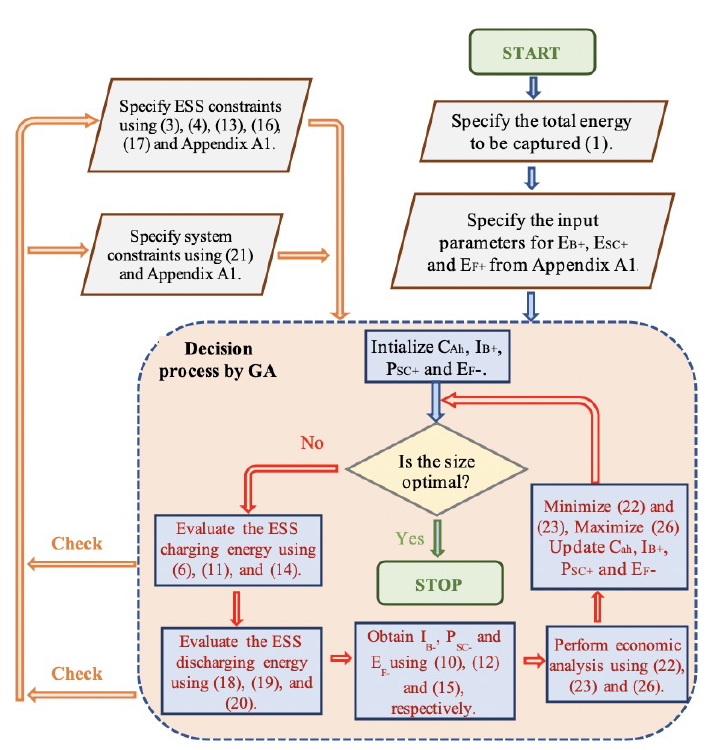
Figure 3. Flowchart for optimization of